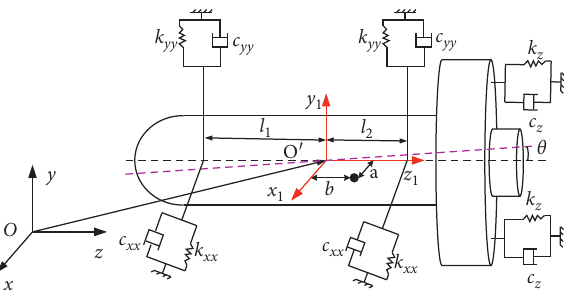
Figure 5: Schematic diagram of spindle inclination